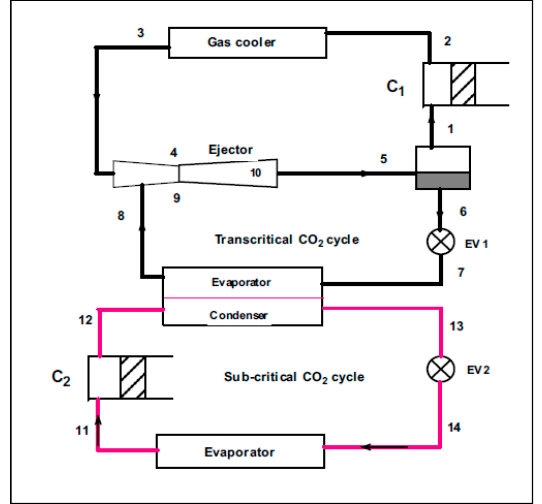
Figure 20. Ejector-expansion based cascade refrigeration cycle layout [191].